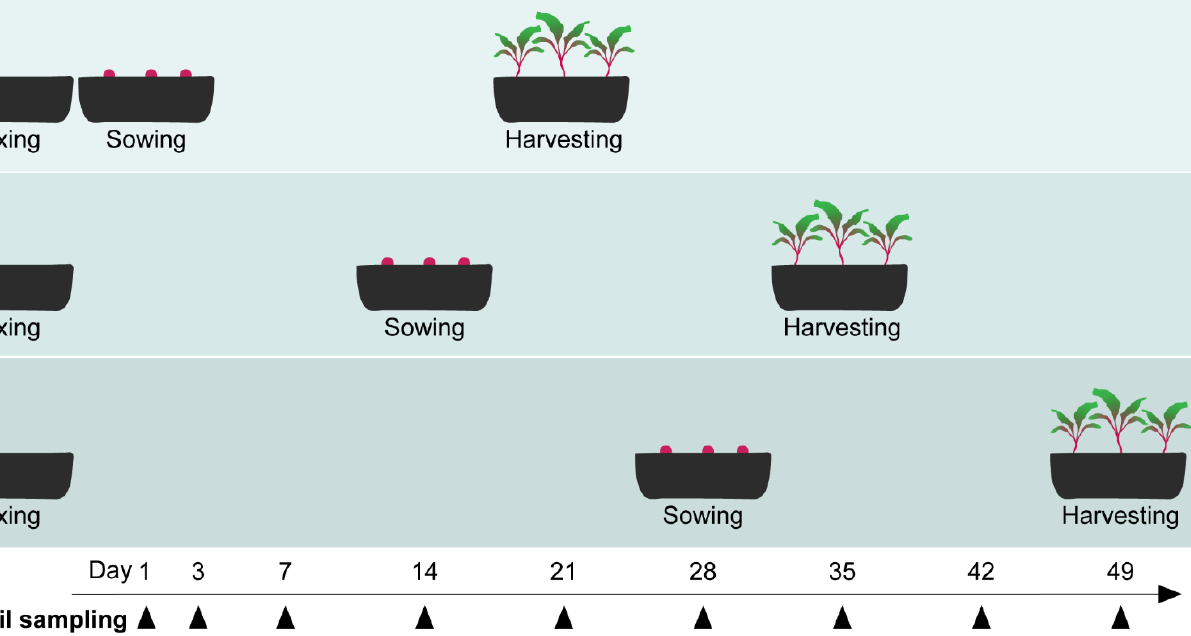
Figure 2. Experimental design of the ToS experiment. For T1, T2, and T3, the time gap in between soil organic amendments (day 0) and sowing is shown. The plant-growth period was the same for T1, T2, and T3 (3 weeks). Black arrows indicate the days when soil was sampled non-destructively from all pots. Additionally, at harvesting, root and shoot parts were collected. All pots were simultaneously incubated in a greenhouse.